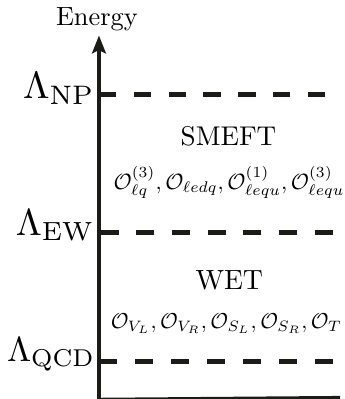
Figure 5 . Relevant scales for the study of the B anomalies. The dashed lines indicate the thresholds between di(cid:11)erent